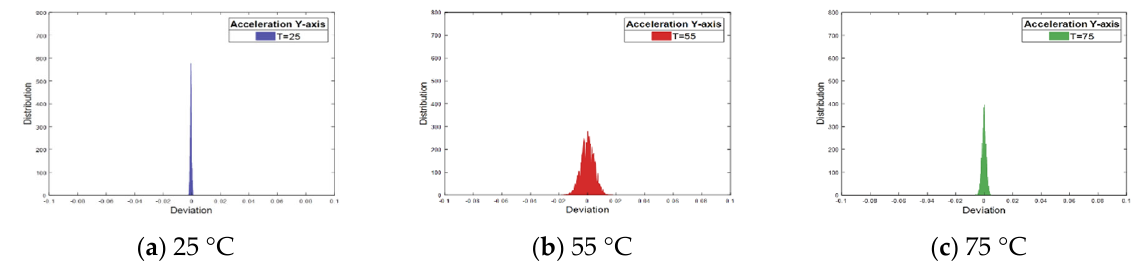
Figure 8. Noise distribution chart of the Y ‐ axis of the accelerometer.